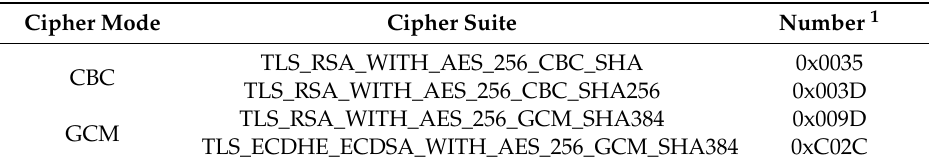
Table 2. Cipher suites used as additional samples.